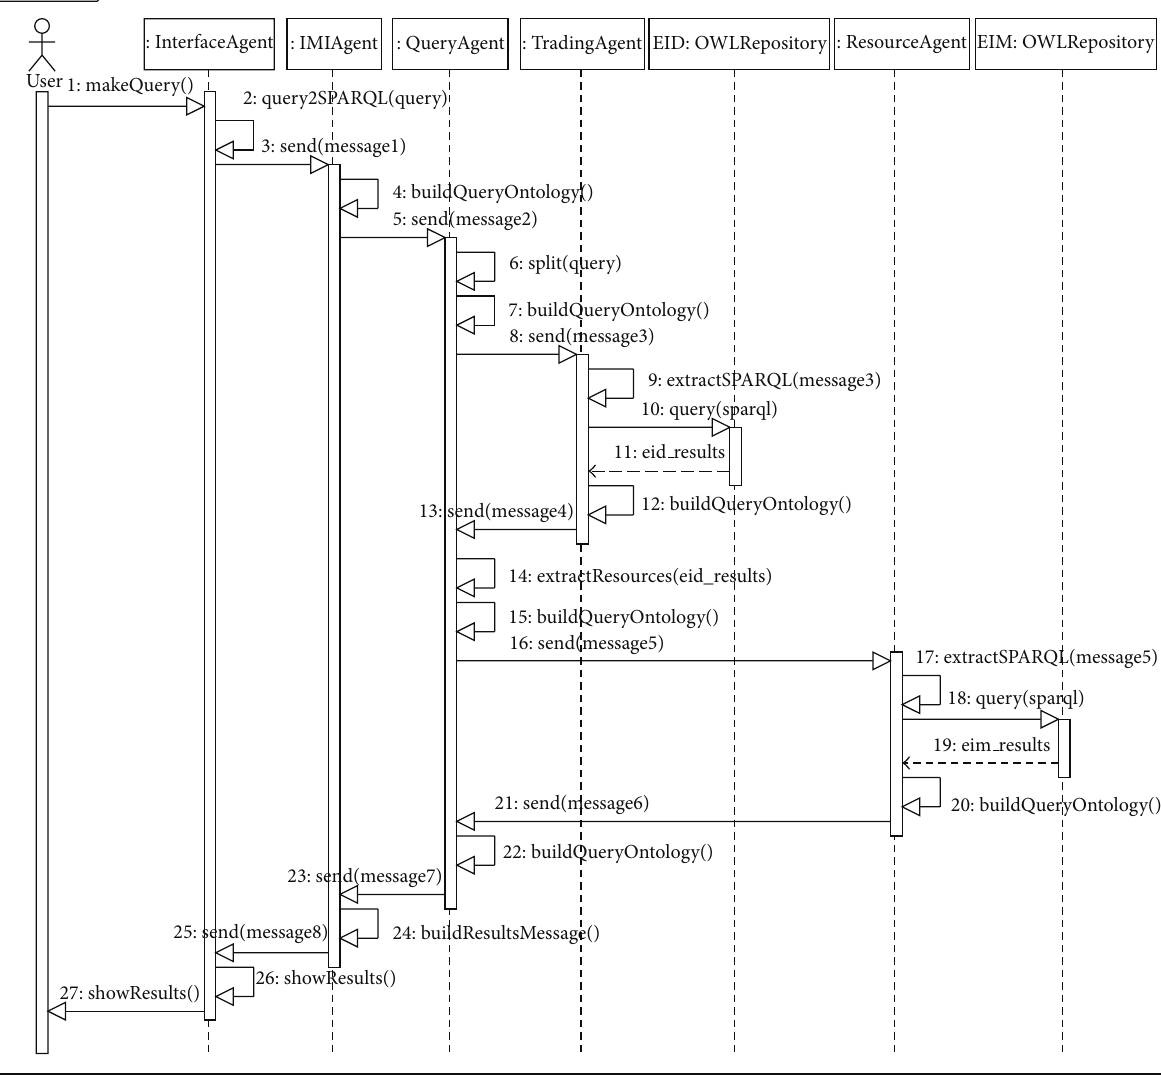
Figure 12: Sequence diagram for Scenario number 2